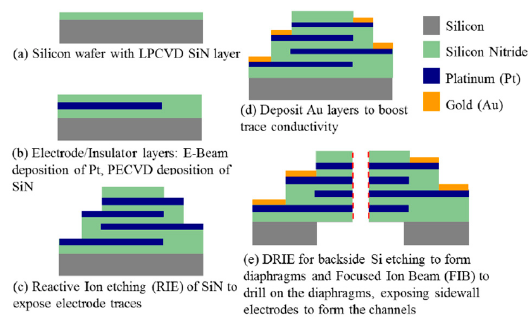
Figure 3. Fabrication process for the sensing element by LTCC technology [1].